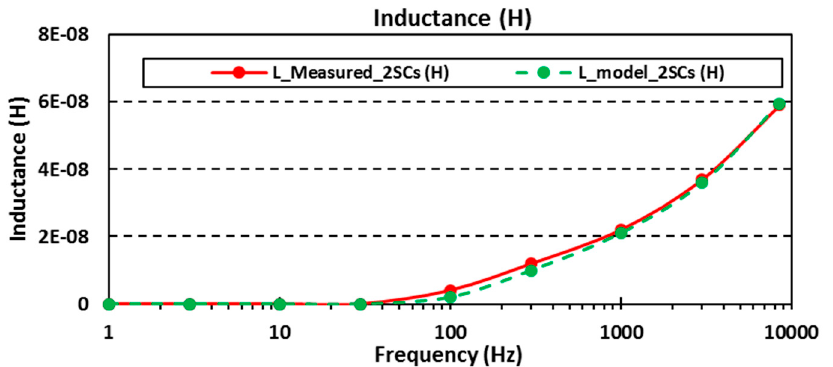
Figure 19. Comparison in the frequency response of the measured inductance and the electrical circuit model of the two SCs charged to 2.7 V.